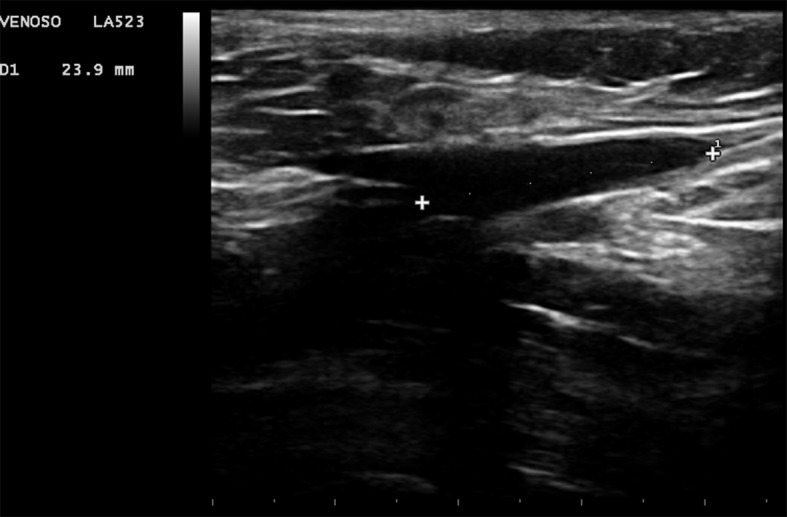
Initial thermal ablation point seen as hyperechogenic lumen approximately 2 to 2.5 cm from the saphenofemoral junction.